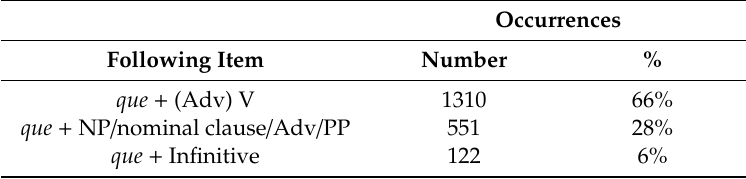
Table 3. The three main linguistic items following que (N =